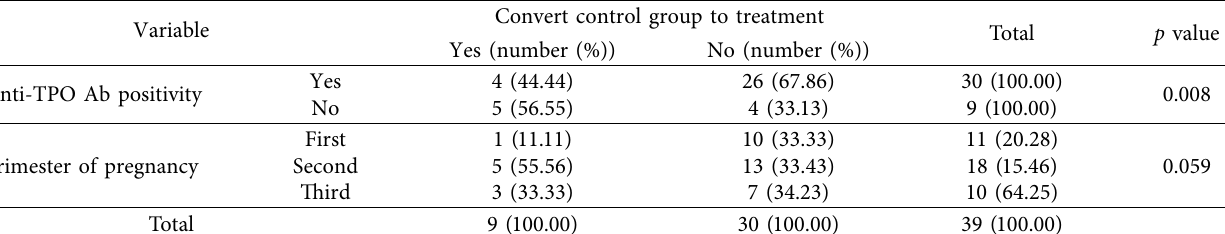
Table 5: Frequency of positive anti-TPO Ab in control cases with increasing TSH required to treatment with levothyroxine during the follow-up period according to Iranian